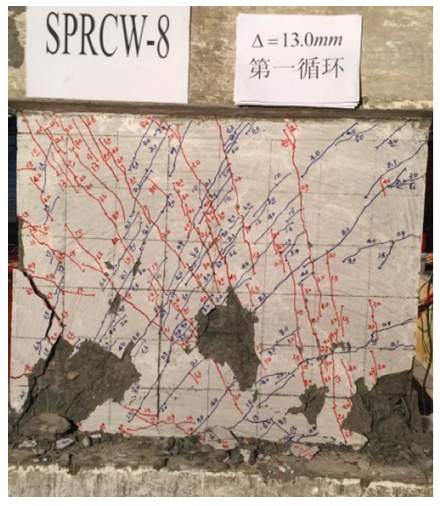
Figure 10: Failure mode of